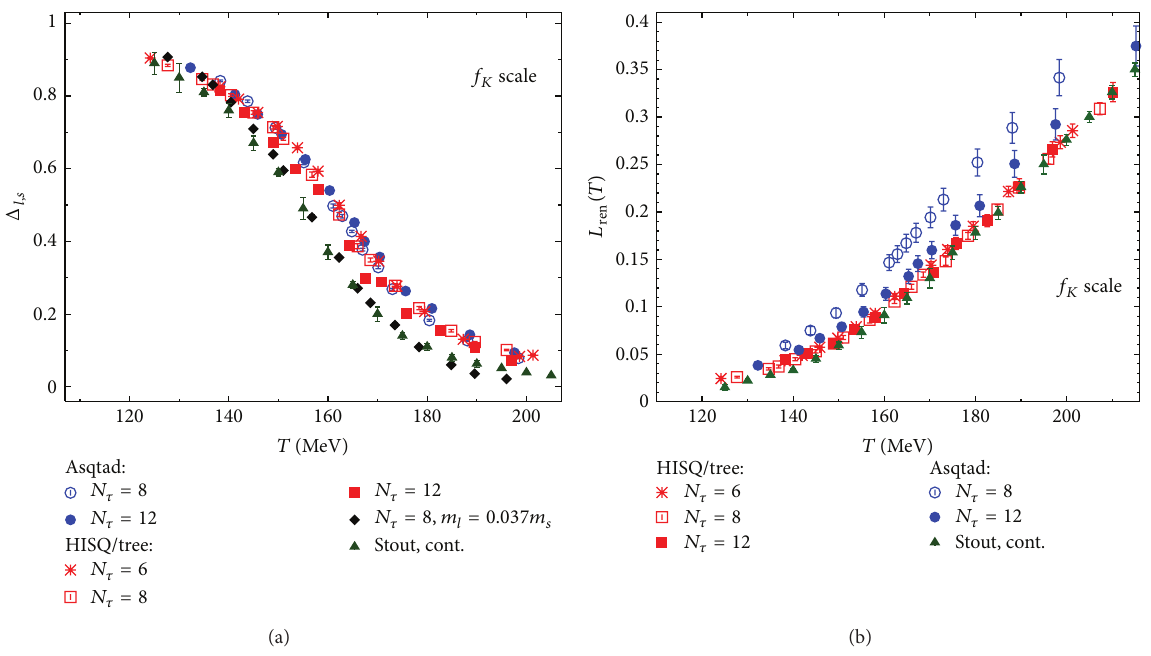
Figure 5: The results for the subtracted chiral condensate (a) and the renormalized Polyakov loop (b) from the HotQCD collaboration, from [49]. These data are compared with the continuum results using stout smeared fermions, from